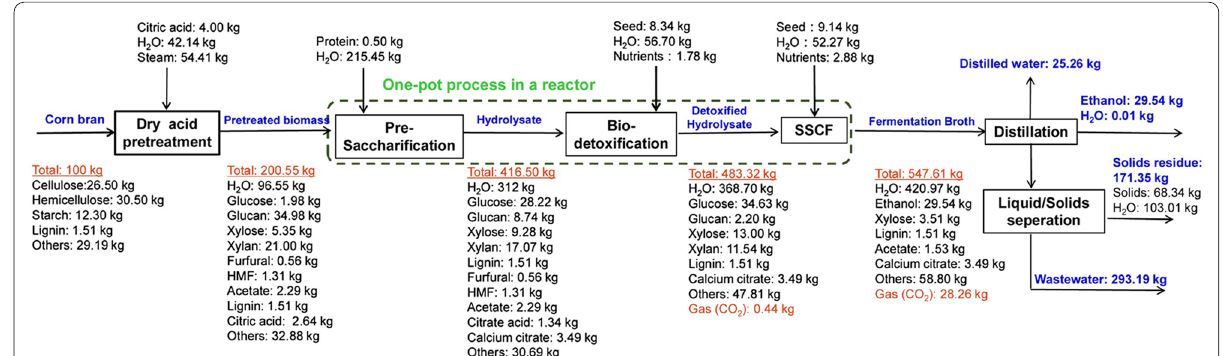
Fig. 5 Feedstock mass balance of cellulosic ethanol production from corn fiber. The steps of pre-saccharification, biodetoxification and SSCF were carried out in the same reactor, which were considered as continuous process (Zhang et al.